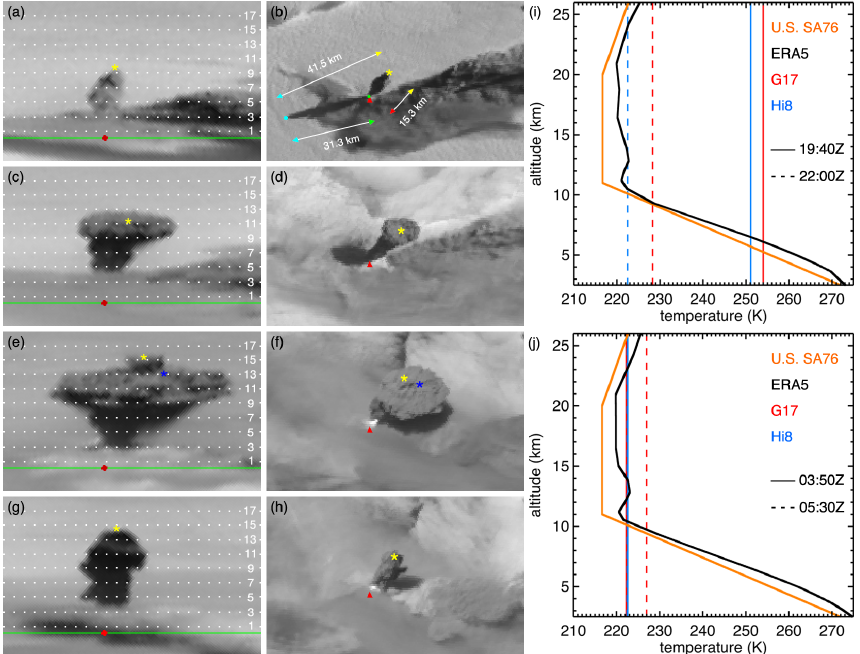
Figure 13. The 21–22 June 2019 eruption of Raikoke: GOES-17 band 2 fixed grid image (8 × magnification) at (a) 19:40UTC on 21 June, (c) 22:00UTC on 21 June, (e) 03:50UTC on 22 June, and (g) 05:30UTC on 22 June and the corresponding Himawari-8 band 3 CEReS V20190123 images in panels (b) , (d) , (f) , and (h) . The red diamond/triangle marks the volcano base, while the yellow asterisks indicate the same plume top feature in the satellite images. In panels (e) and (f) , the yellow and blue asterisks denote the overshooting top and a point on the umbrella cloud, respectively. In panel (b) , the green dot is the start point of the shadow, the cyan dot is the shadow terminus on the marine stratocumulus (Sc) layer, and the double-headed arrows indicate the ellipsoid-projected distance and direction between the points matching the color of the arrowheads. The baseline (solid green) and the odd number isoheights (in km, dotted white) are also drawn in the GOES-17 images. Panels (i) and (j) show the ERA5 temperature profile (black line) at 21:00UTC on 21 June and 05:00UTC on 22 June, the U.S. Standard Atmosphere 1976 temperature profile (orange line), and the GOES-17 and Himawari-8 minimum BT 11 (red and blue vertical lines) corresponding to the satellite